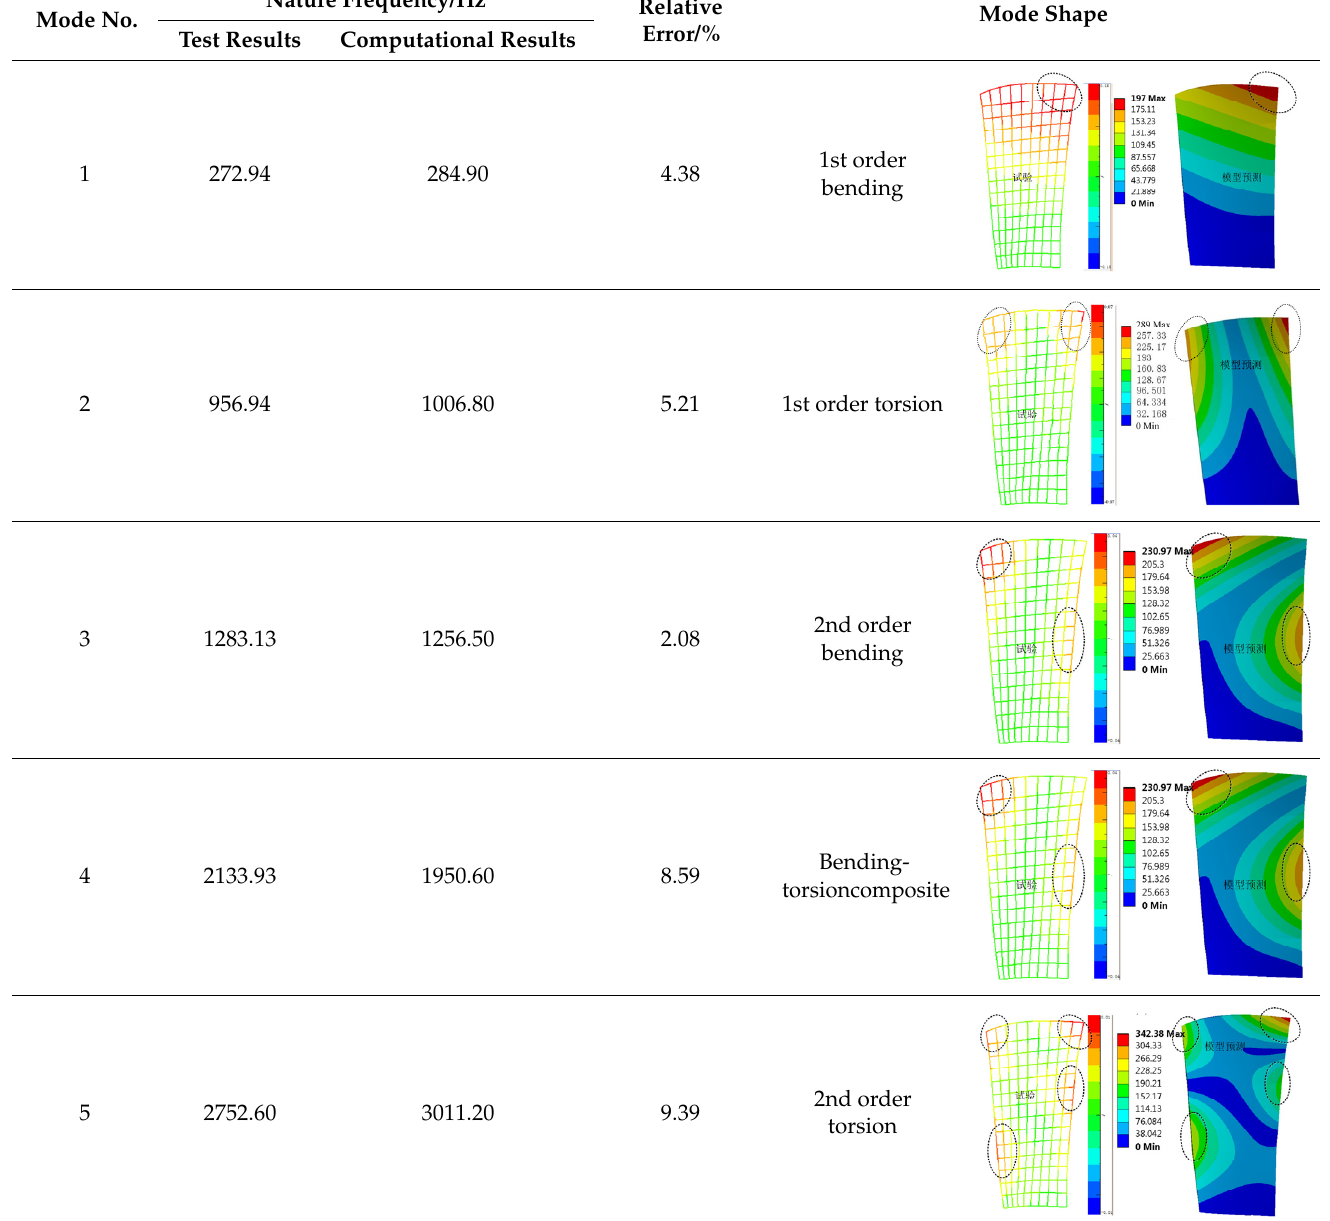
Table 1. Validation results for the finite element model.